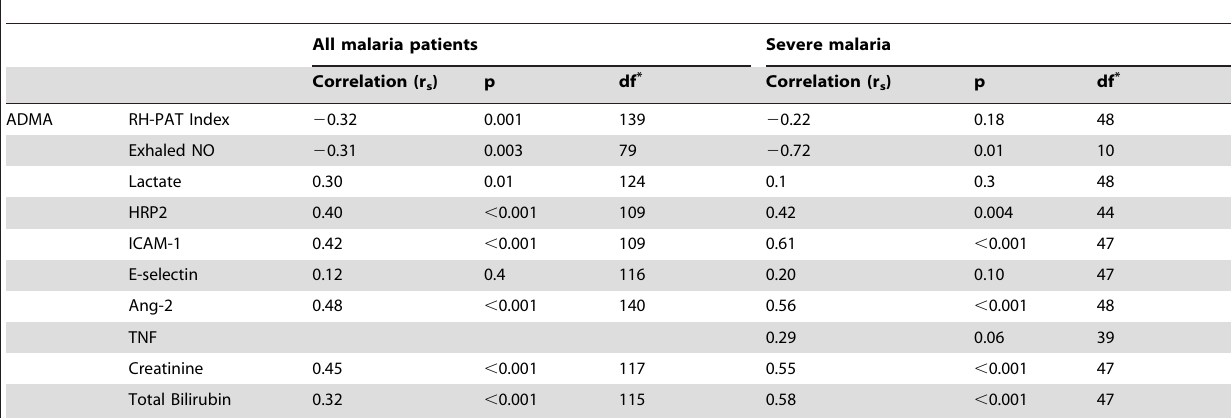
*df=degrees of freedom.